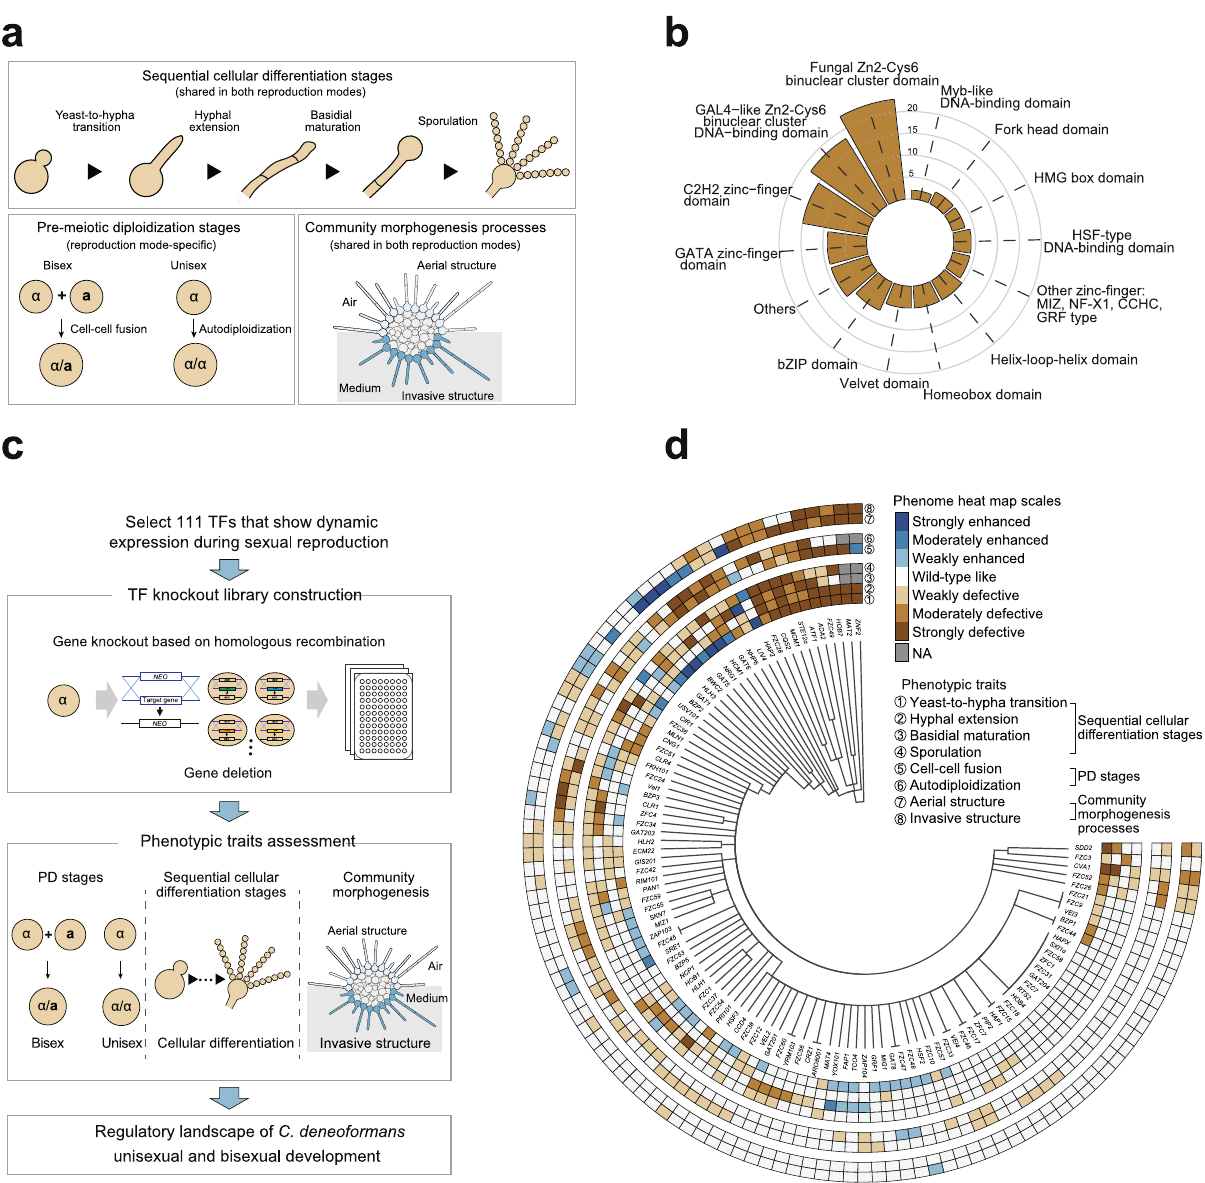
Fig. 1 | Construction and functional pro fi ling of a gene-deletion library for transcription factors in C . deneoformans . a Schematic diagram showing mating colonymorphogenesisandvarioussexualstagesduring C.deneoformans unisexual or bisexual reproduction. b Pie chart showing the classes and distribution of 111 C . deneoformans TFs. Each TF was classi fi ed based on the DNA binding domains predicted using Superfamily (http://www.supfam.org/SUPERFAMILY/) and Pfam (http://pfam.xfam.org/) databases. DNA binding domain(s) of each TF are listed in Supplementary Date 1. c Flowchart of the construction of the C . deneoformans TF